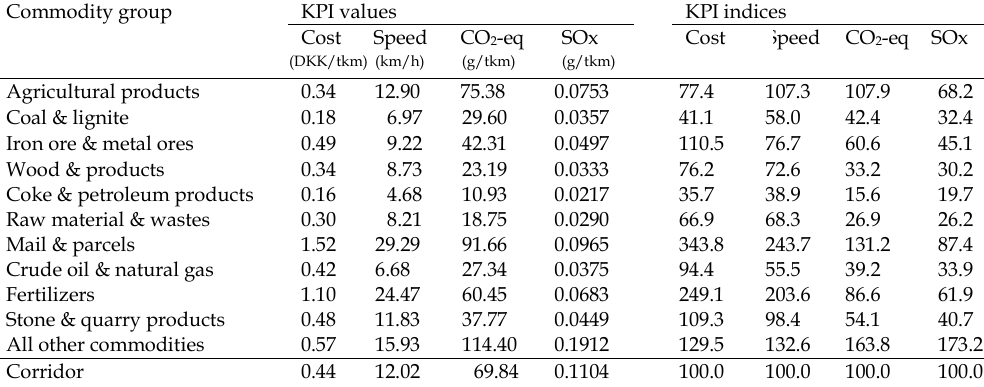
Table 3. KPI values and indices by commodity group Commodity group